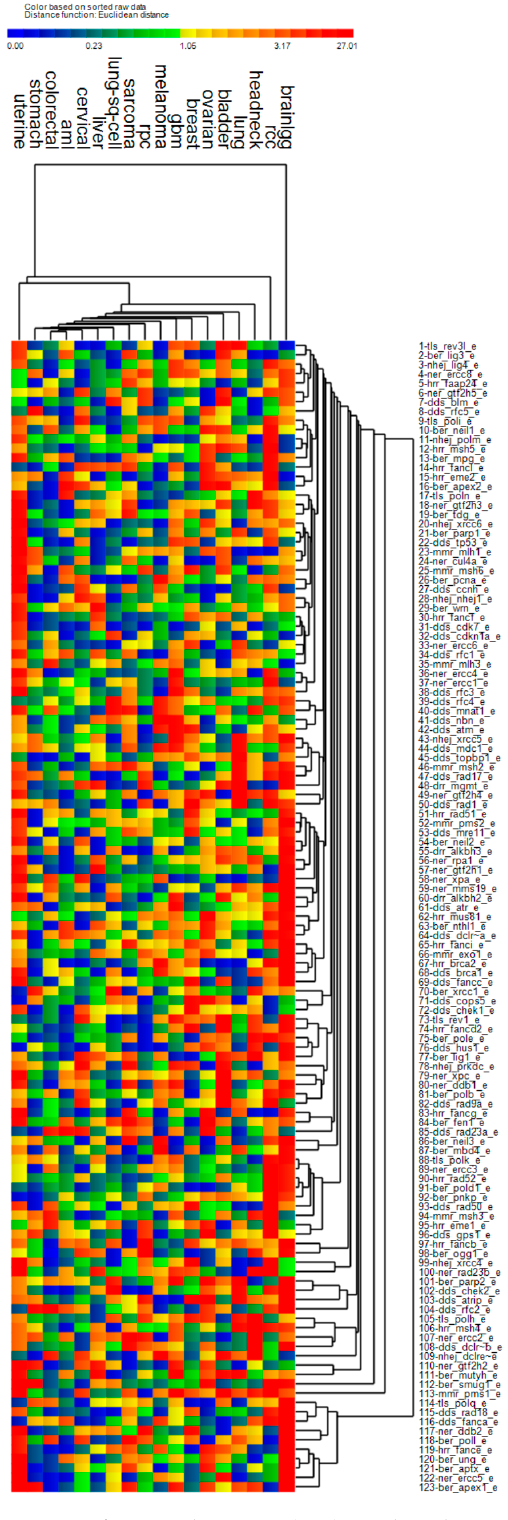
Figure 2. Chi-squared test statistics from Kaplan-Meier (KM) tests based on DNA repair gene expression adjusted for age and stage at diagnosis, and the PCNA metagene. Gene-specific adjusted expression values were split into two groups based on a median cut-point. Heat map colors represent chi-squared values for each KM test, where blue-green-yellow-orange denotes non-significant tests and red denotes significant tests, i.e., χ 2 > 3.84.